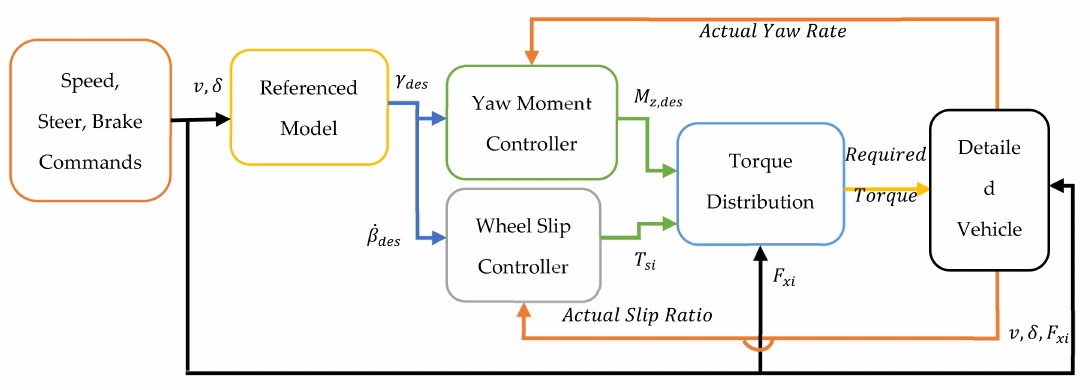
Figure 4. Yaw rate controller